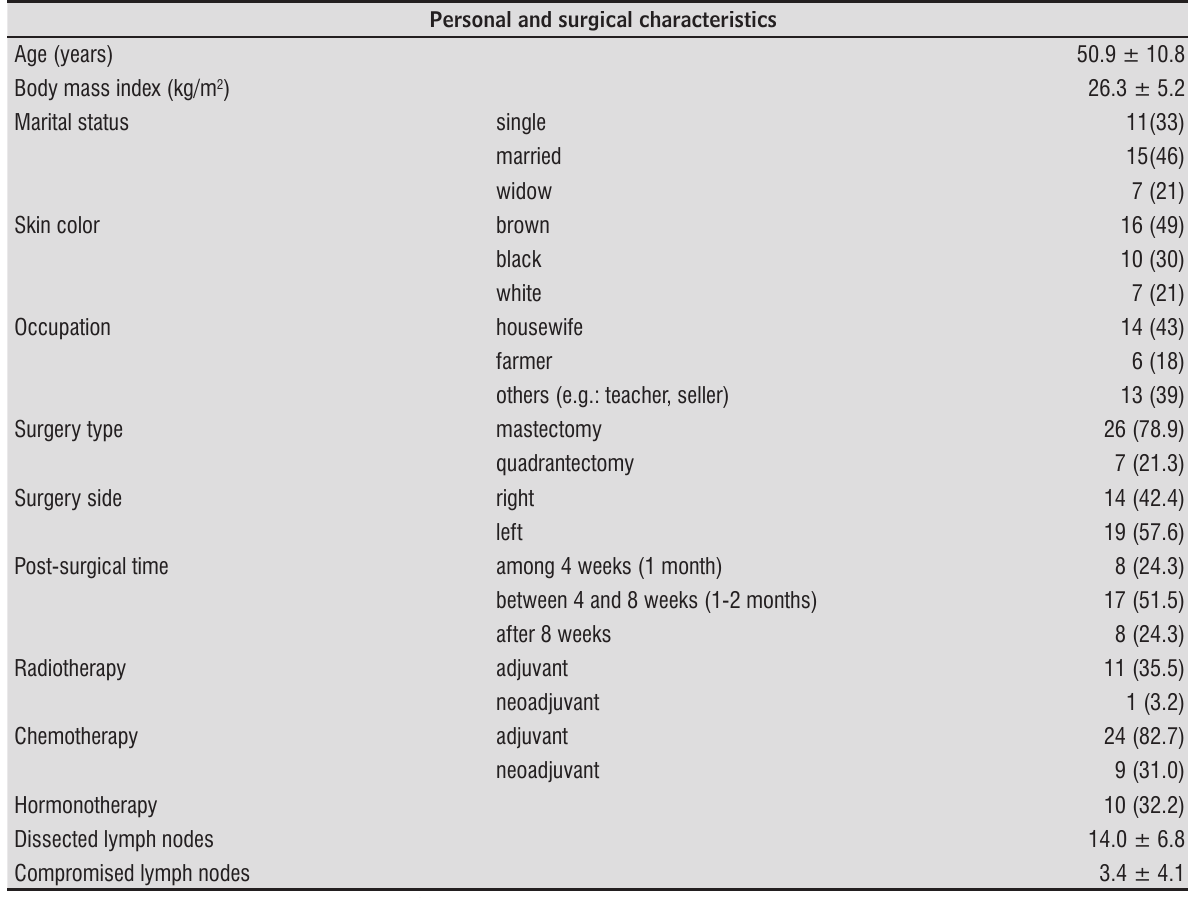
Table 2 - Sample clinical and surgery characteristics (n = 33) Personal and surgical